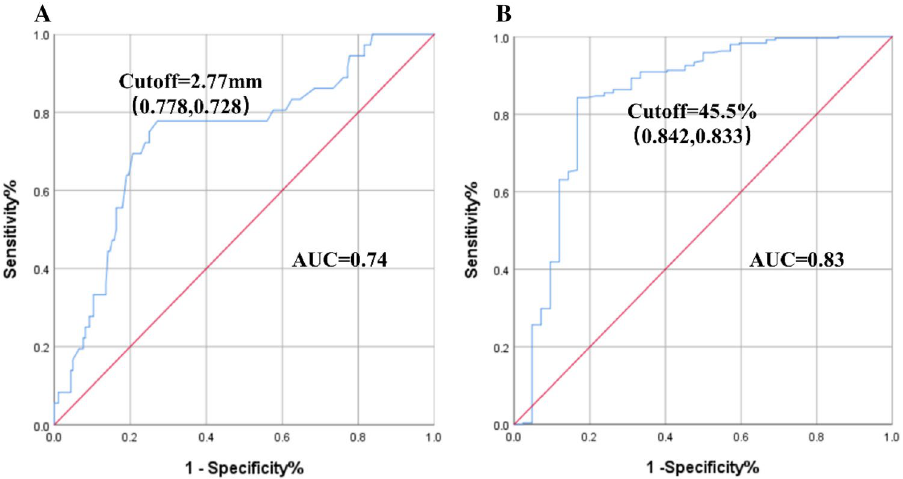
Figure 3. Receiver operating characteristic (ROC) curve identified the threshold of IMA and %VT. ( A ) The ROC curve identified the cutoff of the IMA diameter as 2.77 mm. ( B ) The ROC curve identified the cutoff of the thrombus proportion in the aneurysm sac as